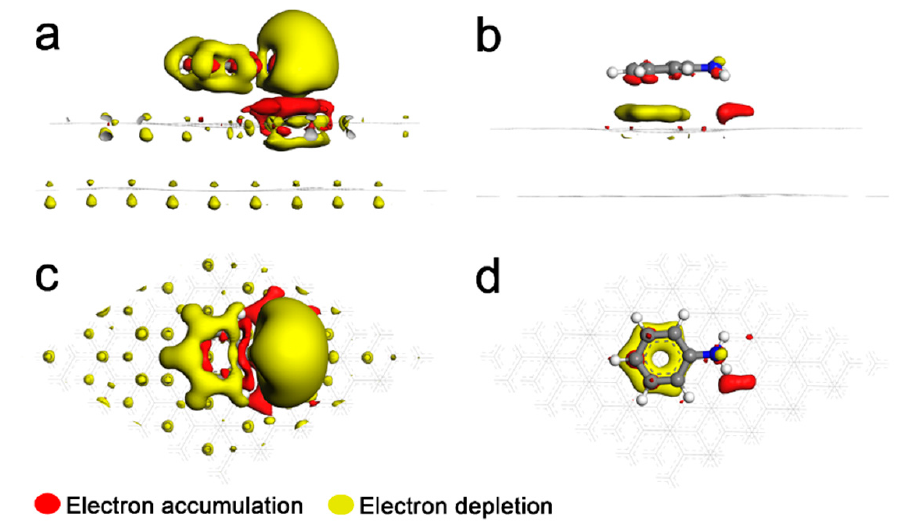
Figure 3. First-principles simulations of the adsorption models. Electronic density difference between bilayer graphene and ( a , c ) ANI + , and ( b , d ) ANIm with an isovalue of 0.003.